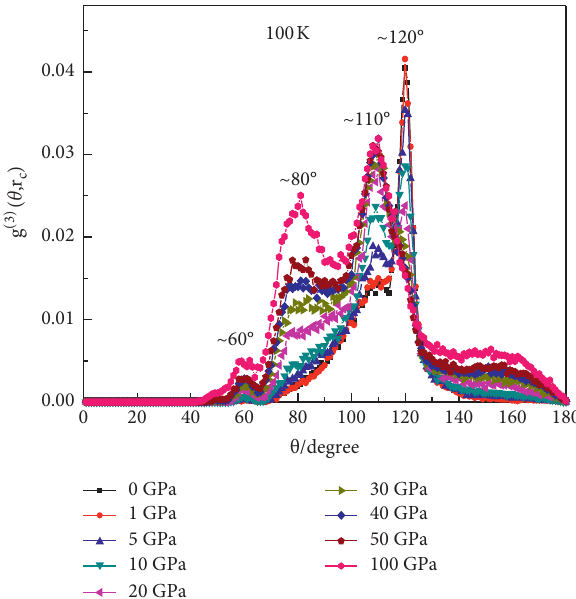
Figure 7: BADF of SiC after solidification under different